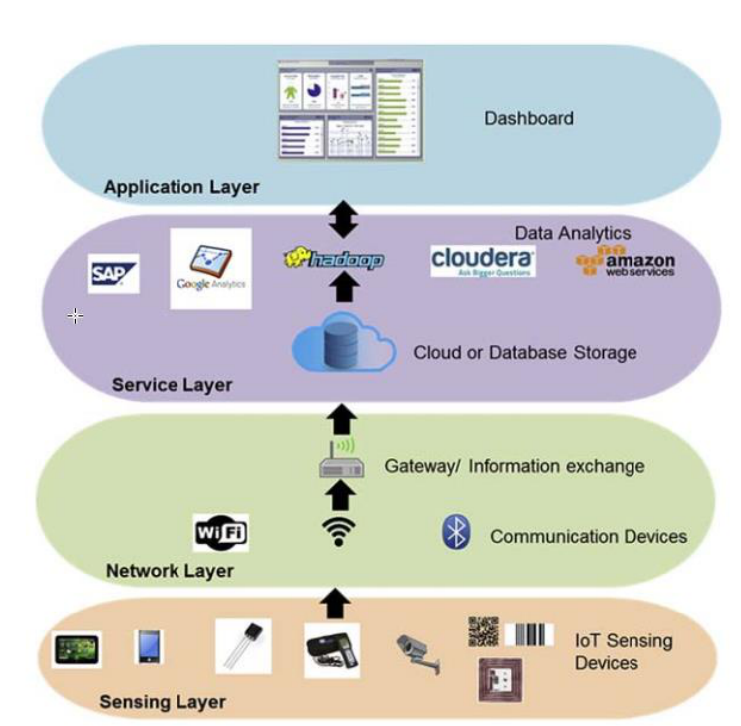
Fig. 2. IoT architecture in the food supply chain